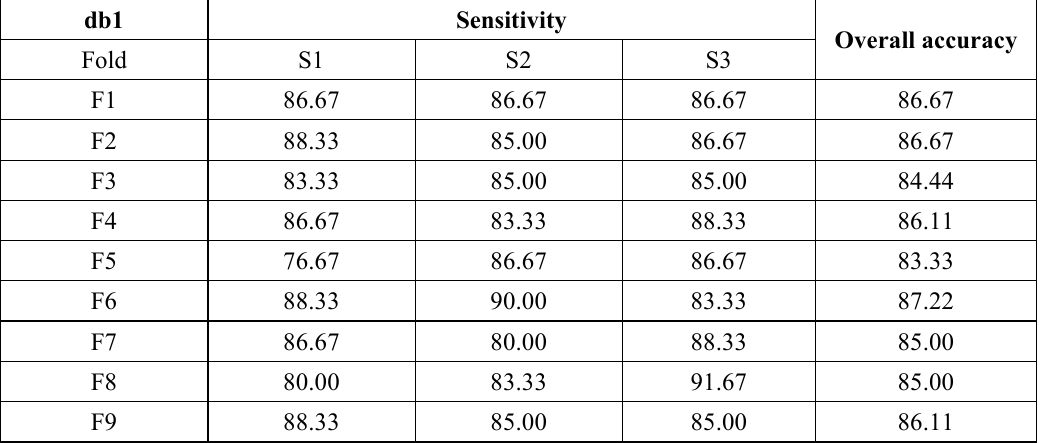
Table 6. Performance analysis of using other